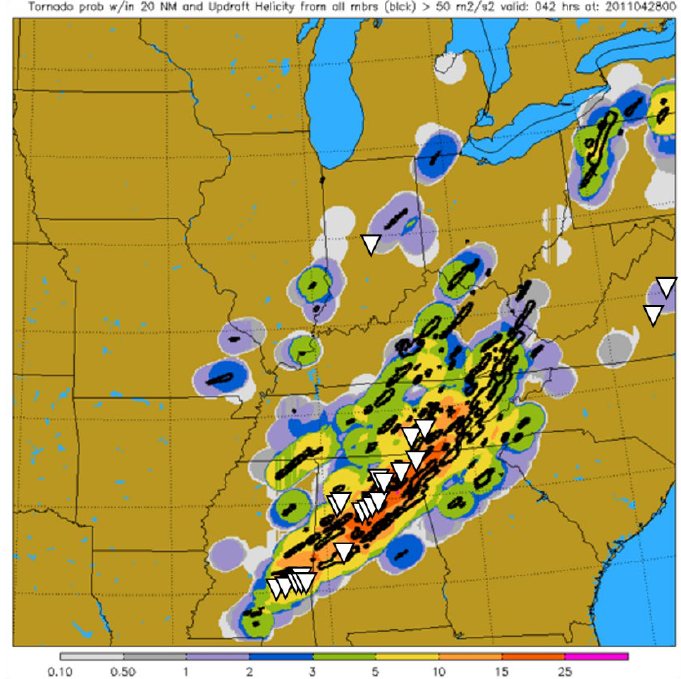
Figure 7. 42-h 4-km mesoscale ensemble probability (percent) of a tornado within 20 nautical miles Figure 7. 42-hour 4-km mesoscale ensemble probability (percent) of a tornado within 20 nautical